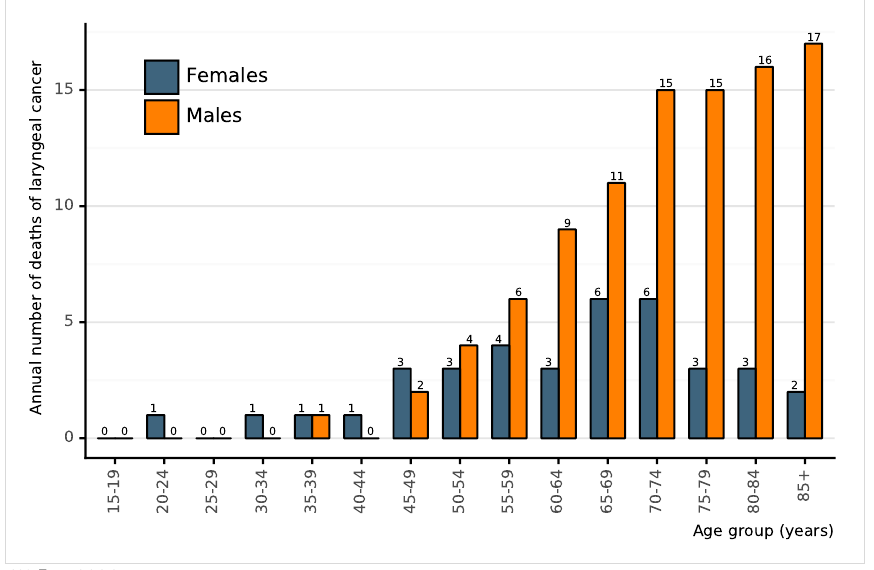
Figure 51: Annual number of deaths of of laryngeal cancer in Peru (estimates for